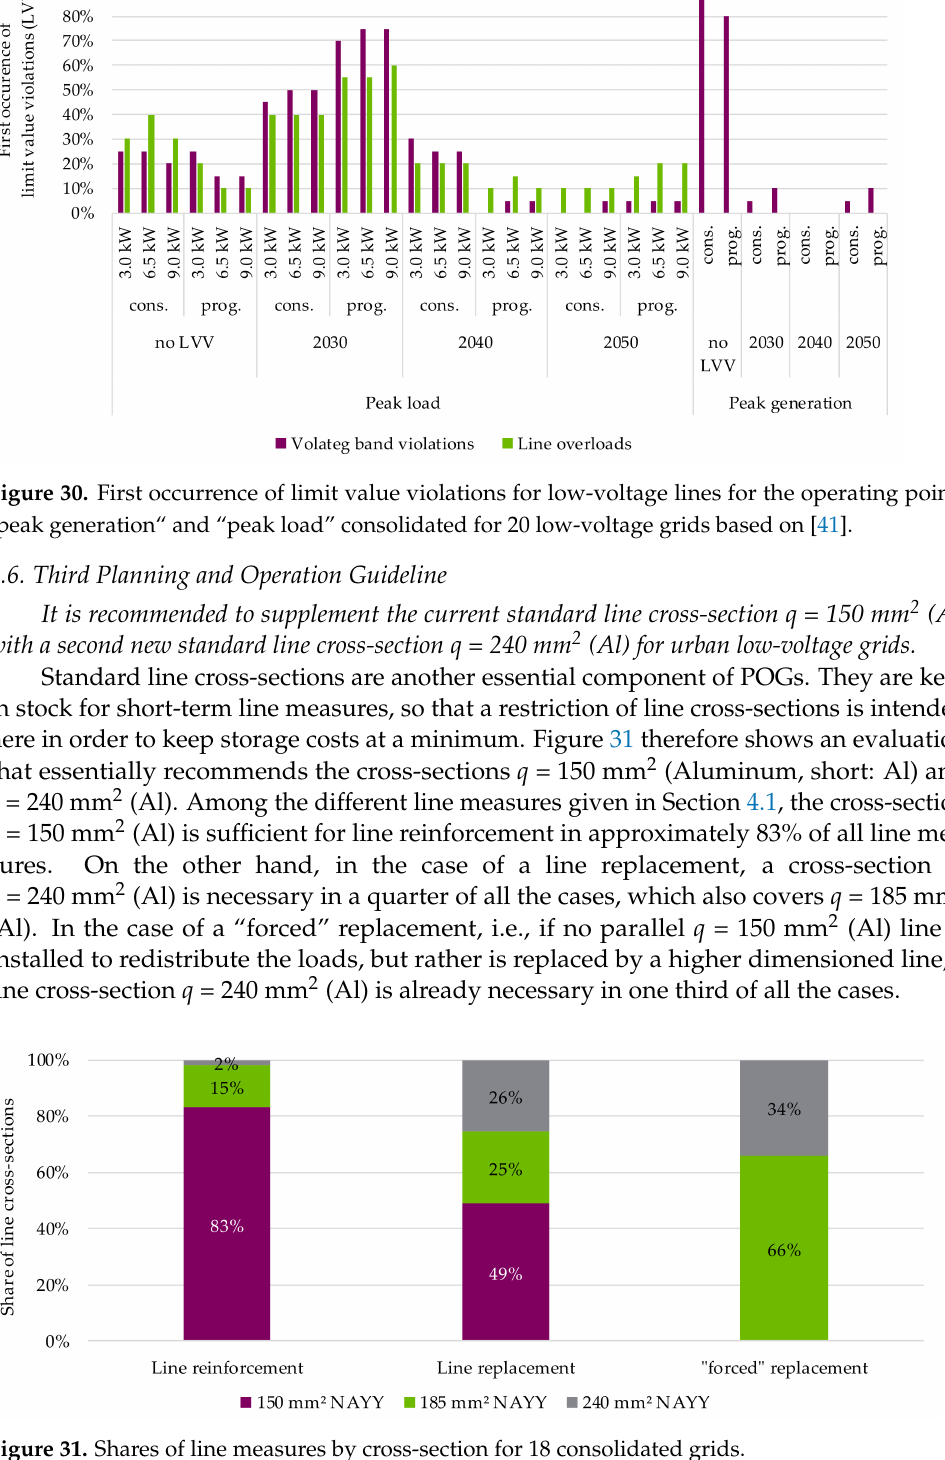
Figure 31. Shares of line measures by cross-section for 18 consolidated